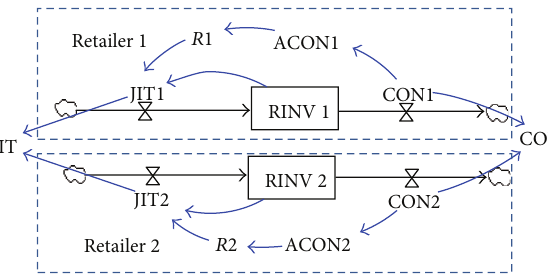
Figure 12: Retailers’ sales subsystem causality